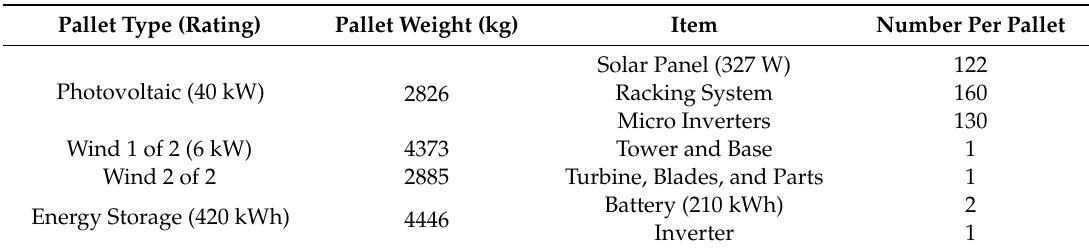
Table 5. HES component pallet divisions for